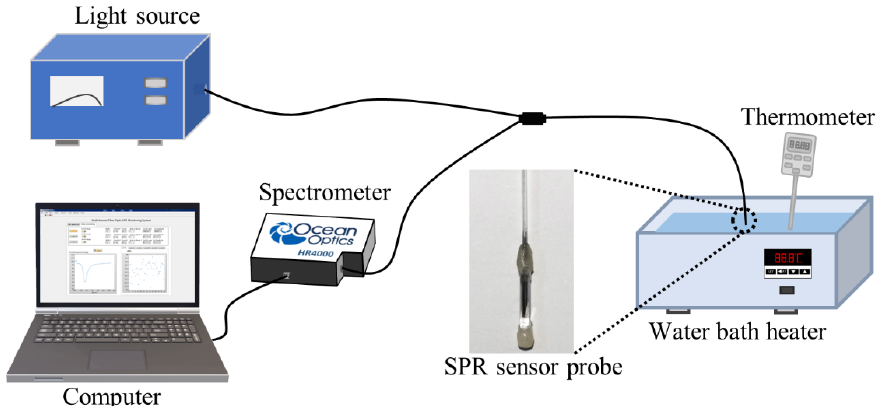
Figure 3. The sketch diagram of the sensing system. Inset: The optical fiber SPR temperature-sensing probe.